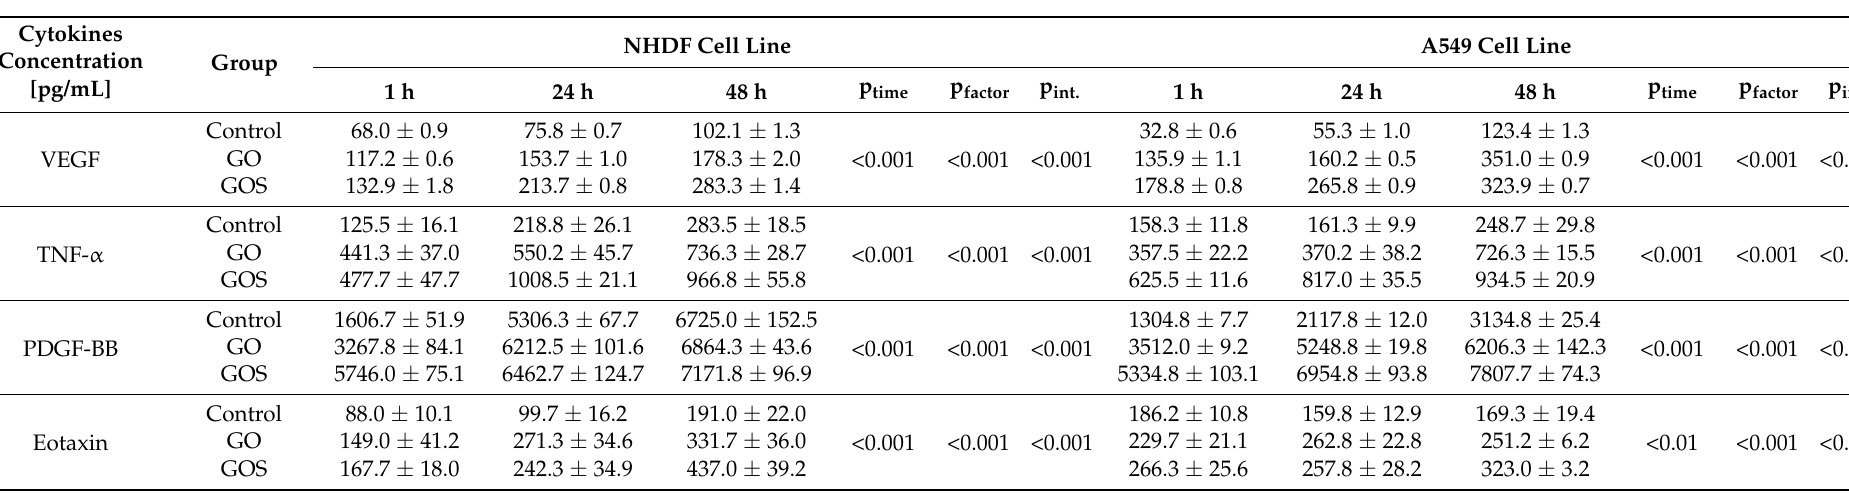
Table 2. Cytokines levels in NHDF (normal human dermal fibroblasts) and in A549 (adenocarcinomic human alveolar basal epithelial cells) cell line measured 1, 24, and 48 h after exposure to ultrapure (GO) or manganese ions-contaminated graphene oxide (GOS). Categorical factors: time (time passed from exposition to GO/GOS to samples collection), factor (GO or GOS vs. control group), int. (interaction between time and type of factor (GO vs. GOS)). The results are presented as mean ± standard deviation. Statistical significance was set at a p <